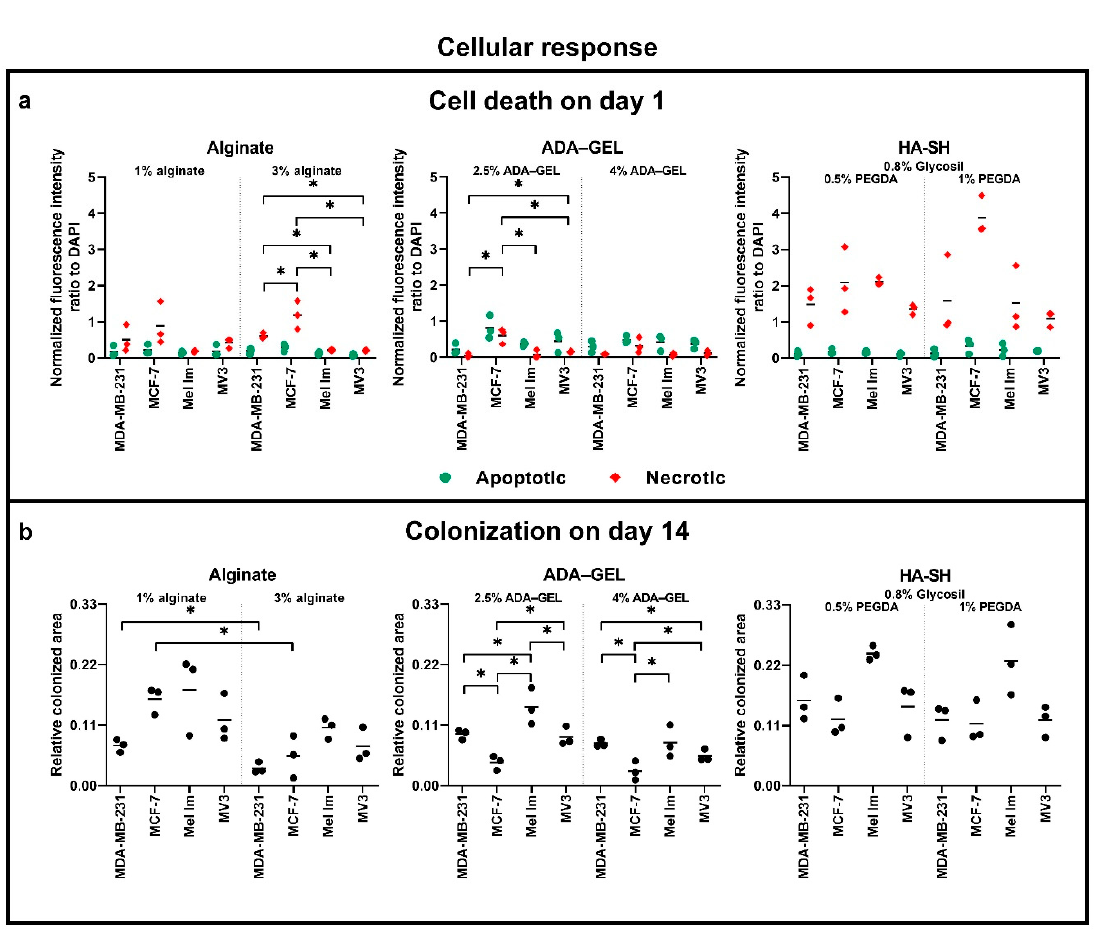
Figure 8. Cellular response of four cell lines in alginate, ADA–GEL, and HA-SH: ( a ) quantification of the apoptotic/necrotic/healthy staining on day one; ( b ) quantification of the colonization in phase-contrast images on day 14; * p ≤ 0.05 Kruskal–Wallis H test, Mann–Whitney U test, not all significances are shown for better clarity but mentioned in the results, n = 3 (one picture each was analyzed).